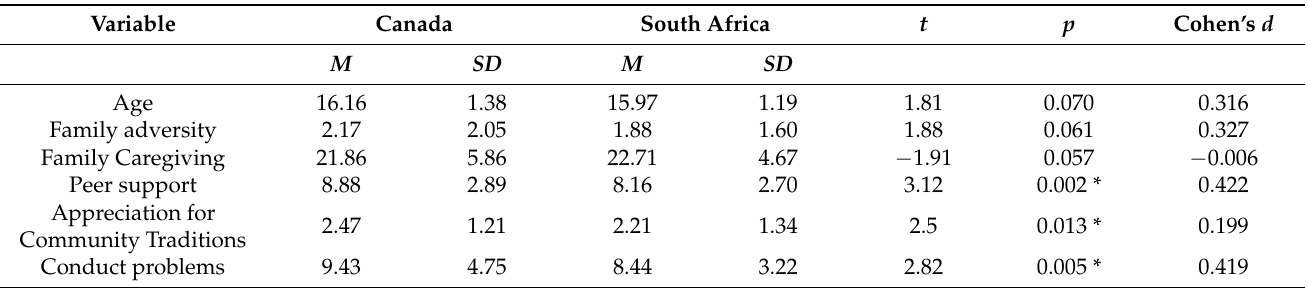
Table 2. Results of independent t -test examining significant differences between the CA and SA